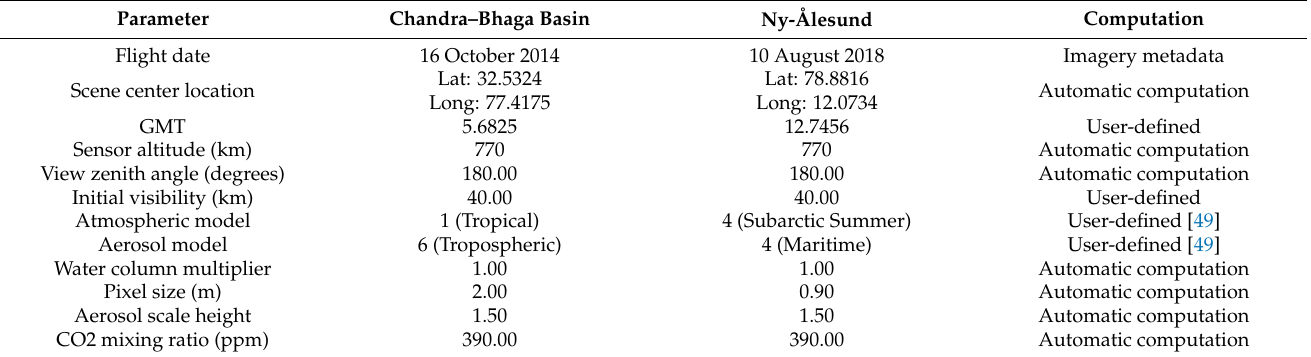
Table 2. Input parameters for FLAASH atmospheric correction.